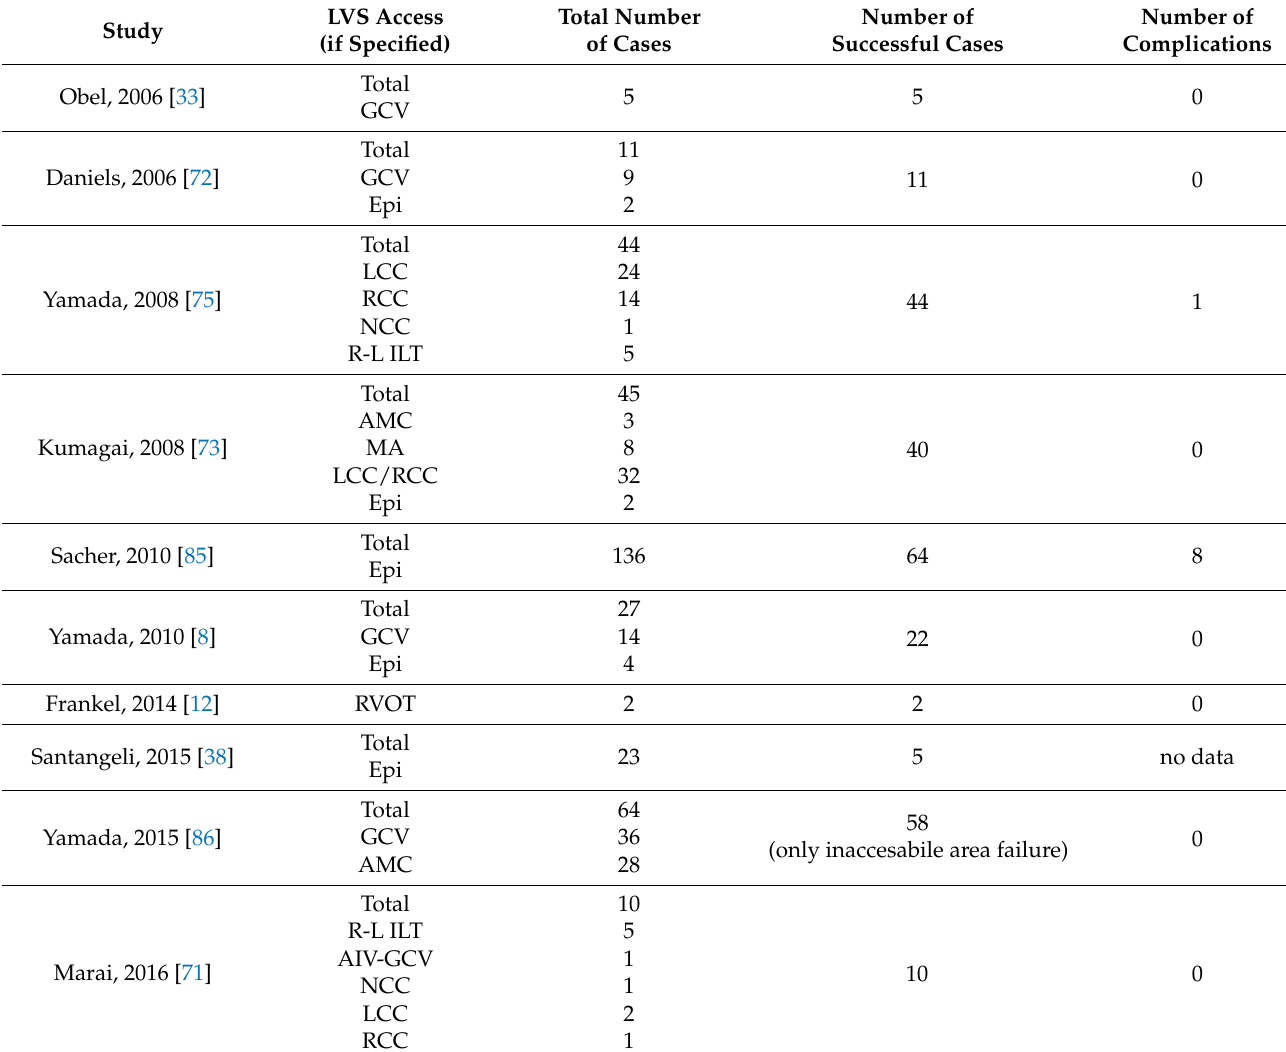
Table 2. Reported success and complication rates of LVS ventricular arrhythmia ablation